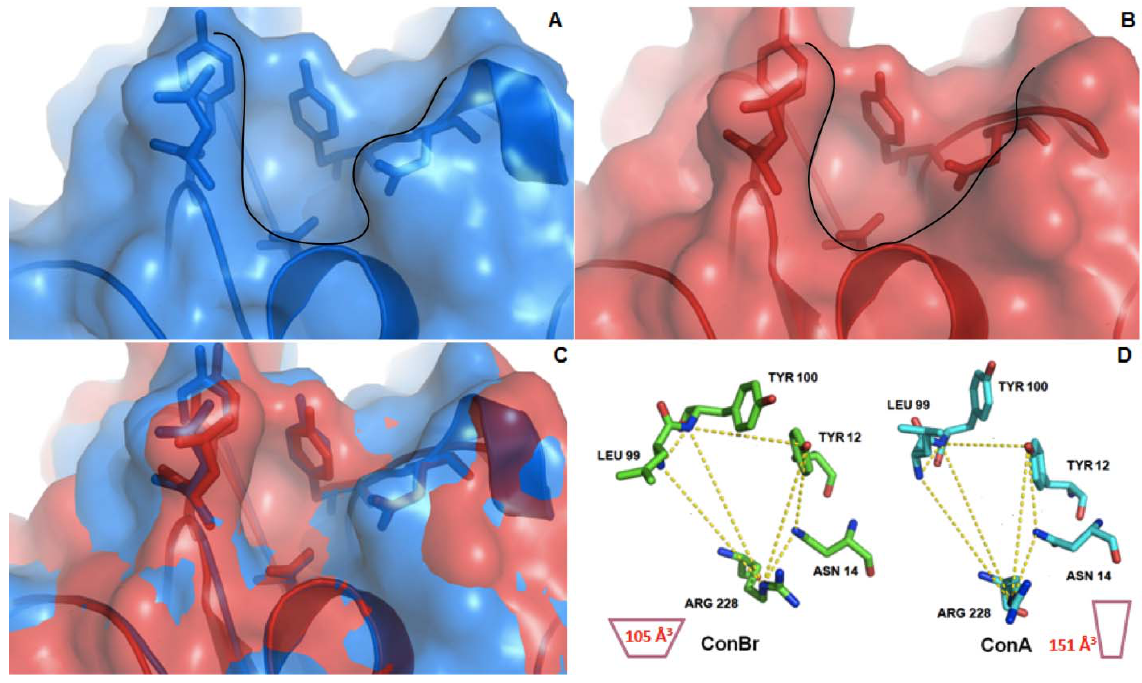
Figure 4. Surface analysis and structure alignment of ConA and ConBr tridimensional structures. ( A ) Carbohydrate binding site of ConA (Blue); ( B ) Carbohydrate binding site of ConBr (Red); ( C ) Structure alignment of ConA and ConBr showing differences in the topology which favors ConBr interactions with LPS; ( D ) Schematic representation of site volume in ConA (right) and ConBr (left). Calculated volume of each site is represented inside the schemes. Black lines in ( A ) and ( B ) delimitate the topology of